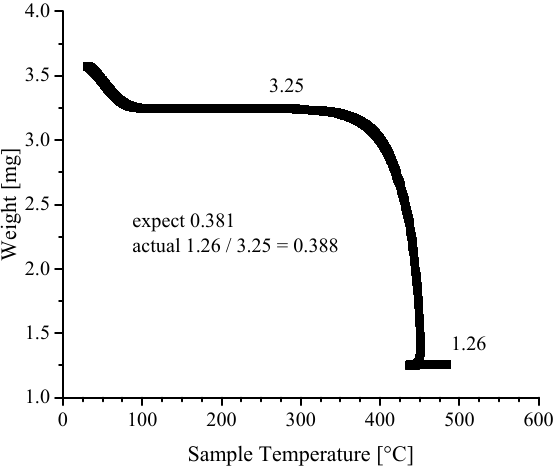
Figure 22. TGA scan in air for crystals of Ni-BpyMe after extracting DMSO guests with methanol. All methanol guests are lost below 100 °C with no further weight loss prior to decomposition. The “expected” value on the plot is the expected ratio of the mass of residual NiO to mass of the guest-free framework as determined from the structure determined by single-crystal X-ray diffraction, whereas the “actual” ratio is the experimentally determined value taken at the indicated points in the scan. See Experimental Section for an explanation of how the ratio is calculated.